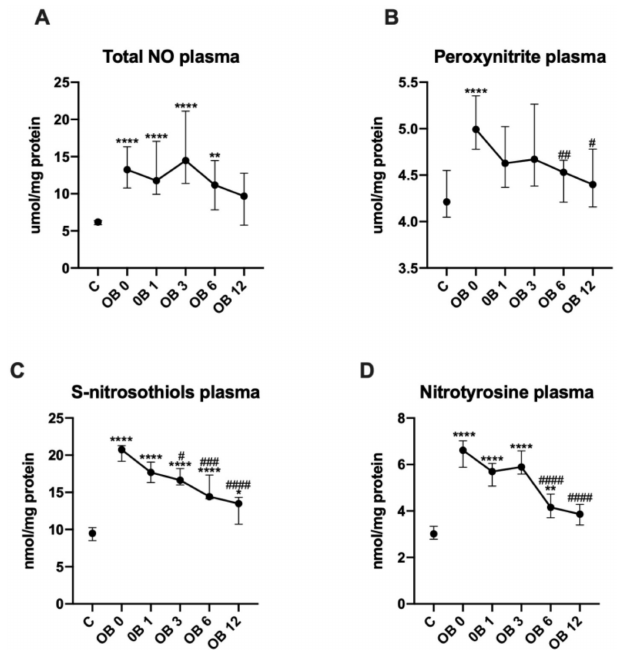
Figure 4. Plasma concentration of total nitric oxide (NO; A ), peroxy-nitrite ( B ), S-nitrosothiols ( C ) and nitro-tyrosine ( D ) of control (C) and morbid obesity (OB); data given as median and 95% Cl; * p < 0.05; ** p < 0.01, *** p < 0.001, **** p < 0.0001 indicate significant di ff erences from control (C); # p < 0.05, ## p < 0.01, ### p < 0.001, #### p < 0.0001 indicate significant di ff erences from morbid